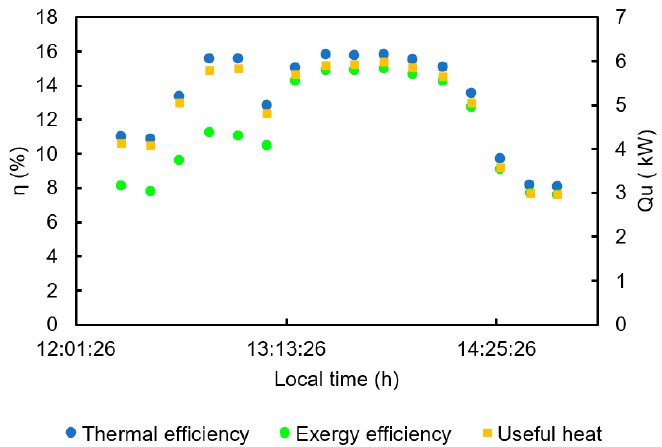
Figure 11. Thermal efficiency, exergy efficiency, and useful heat, 11 December 2017.